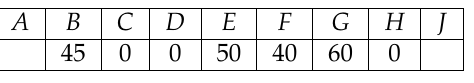
Figure 4. Cost of accommodation in cities.